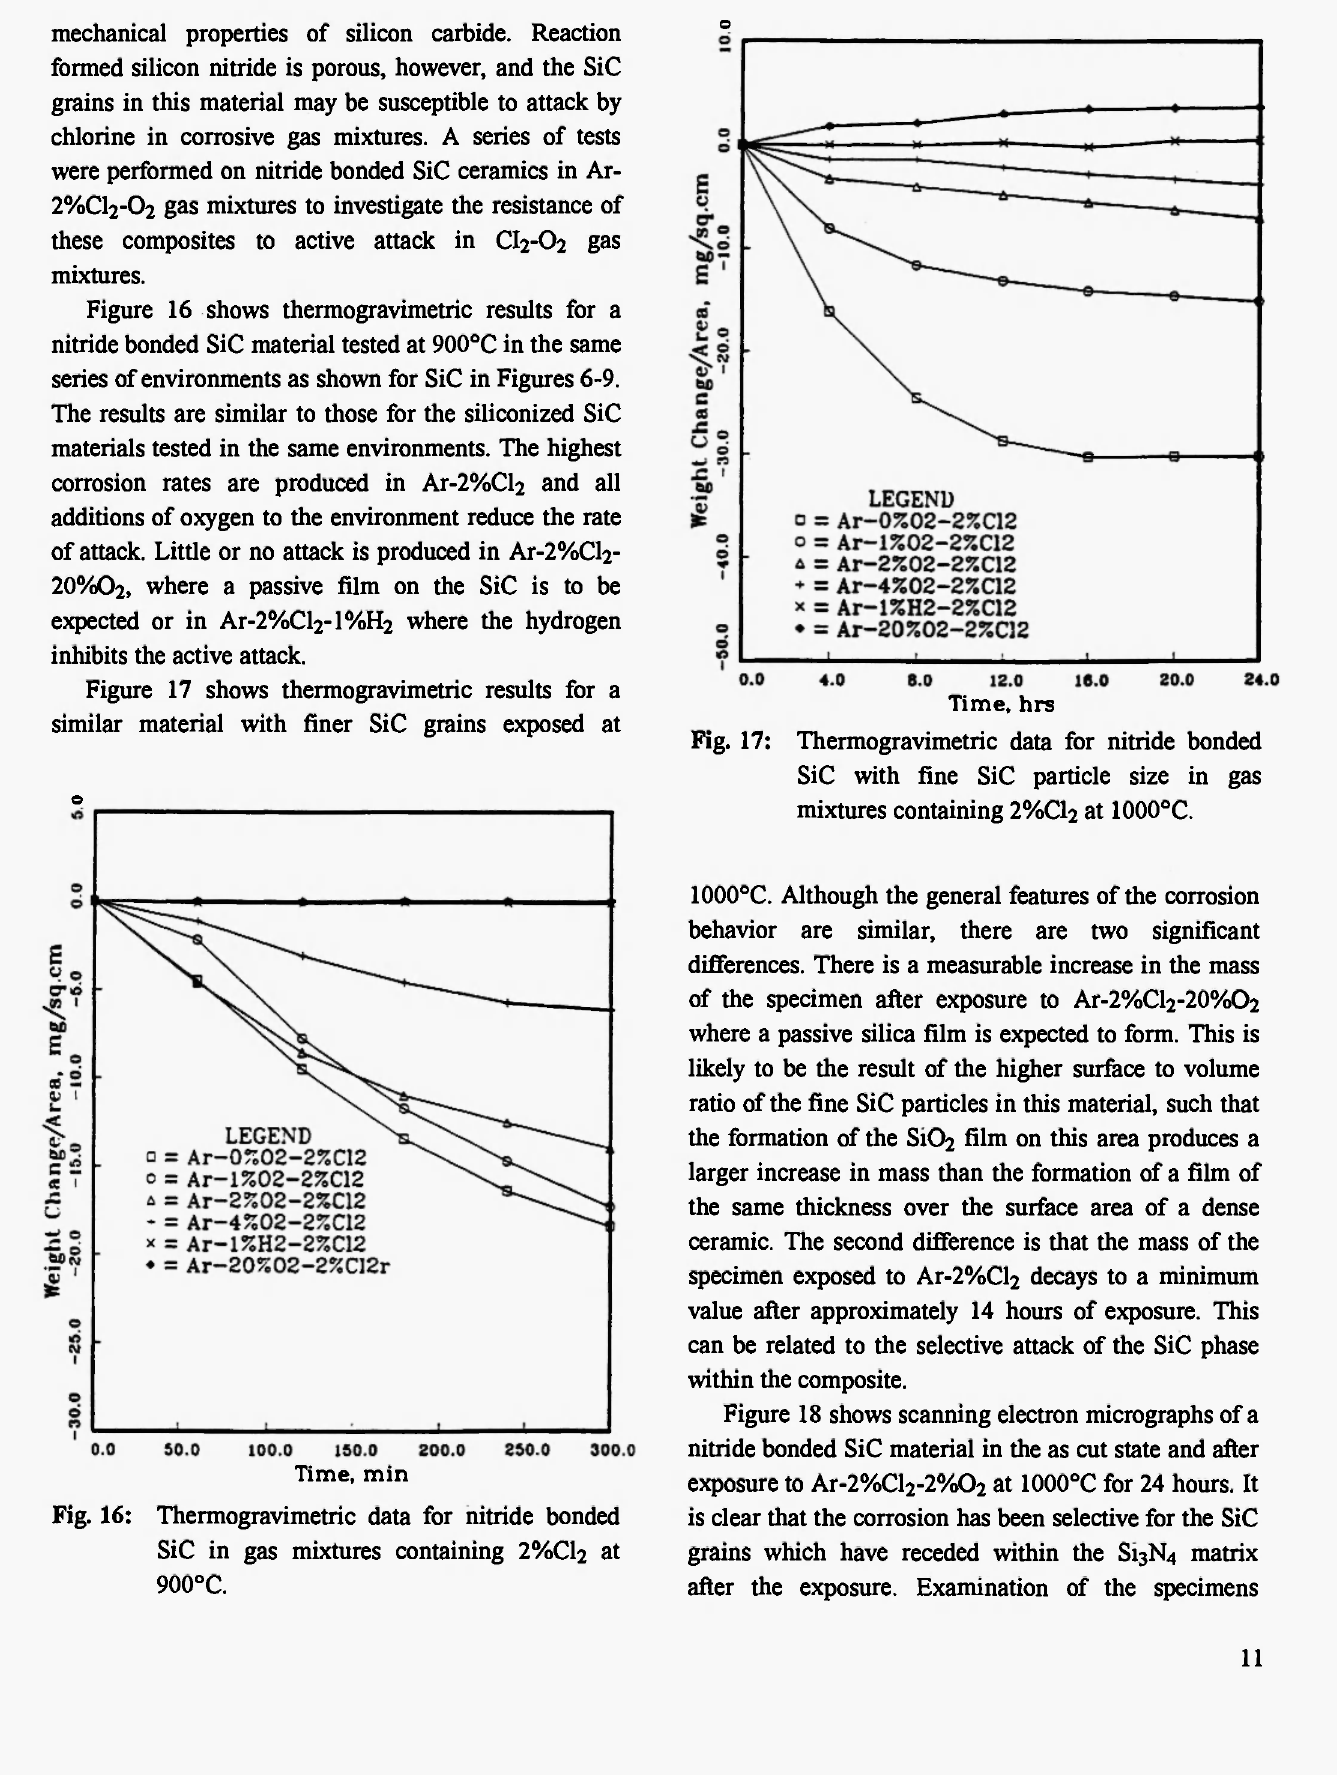
Fig. 16: Thermogravimetric data for nitride bonded SiC in gas mixtures containing 2%Cl2 at 900°C.